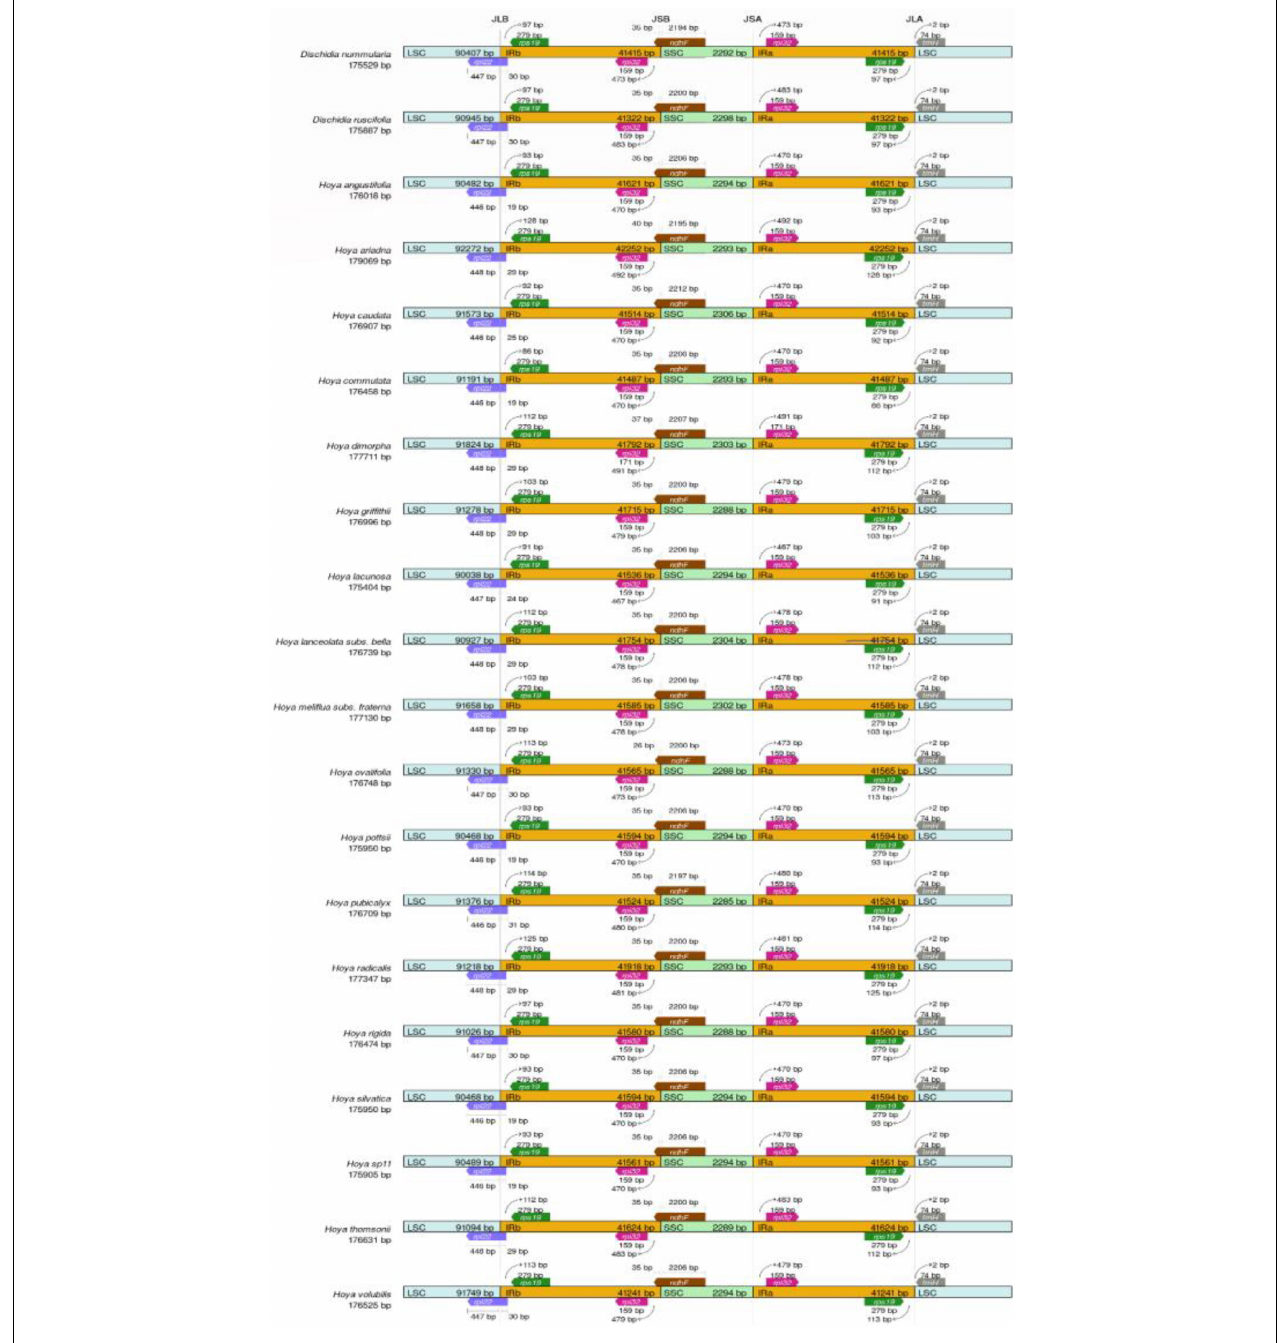
FIGURE 6 | Junction sites comparison of LSC, SSC, and IR for 20 Hoya group plastomes. JLB, junction line between LSC and IRb; JSB, junction line between IRb and SSC; JSA, junction line between SSC and IRa; JLA, junction line between IRa and LSC; LSC, large single copy; SSC, small single